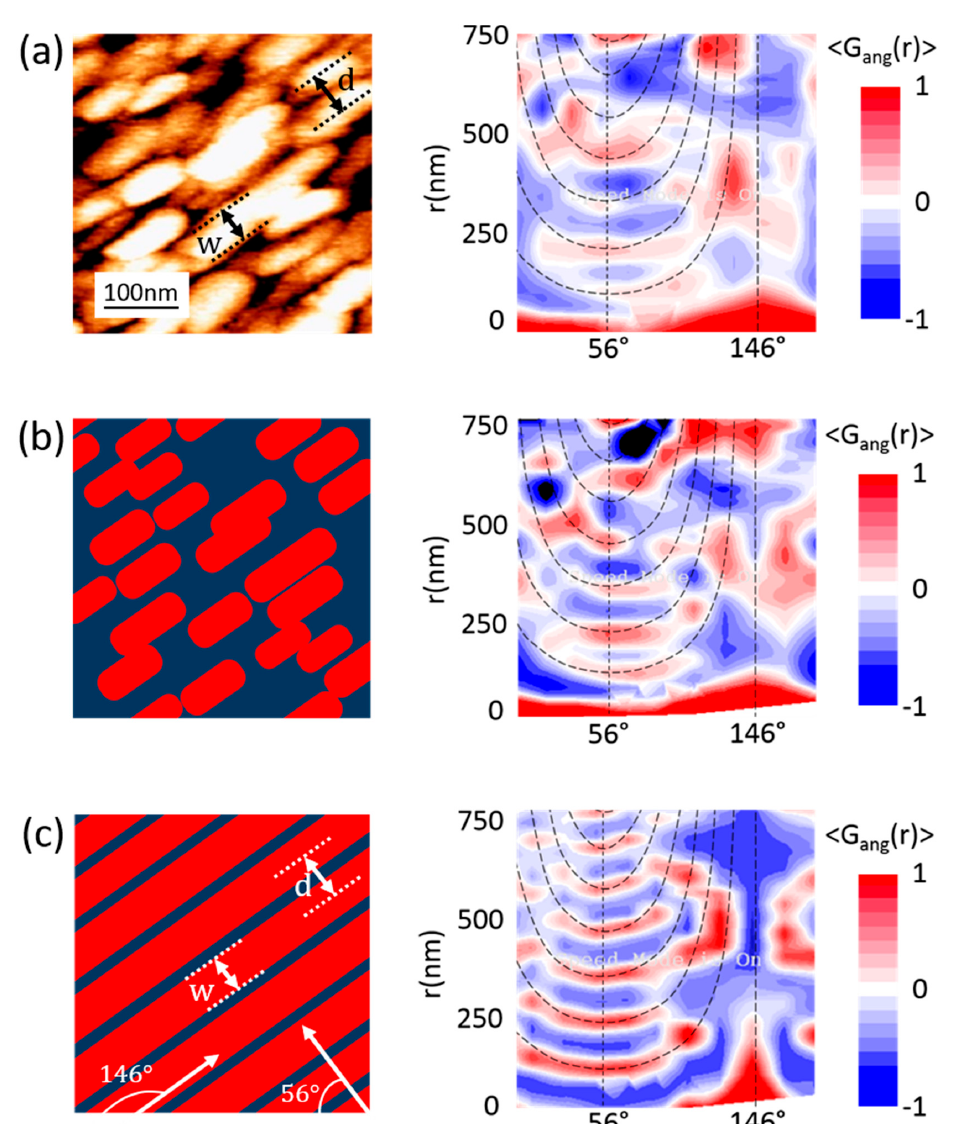
Figure 6. Angle-dependent correlation function < G ang (r)> analysis for: ( a ) uncoated Au sample after 60 days of exposition to C. metallidurans , ( b ) for the same system, but considering topography represented for solid elongated grains and ( c ) perfect stripe system. Black dashed lines in these plots follow the functional form N * d /cos(( α – 90°) – θ ), where N = 1,2,3,…, d = 120 nm, w = 50 nm, α = 146° and θ is the angle (horizontal axis).